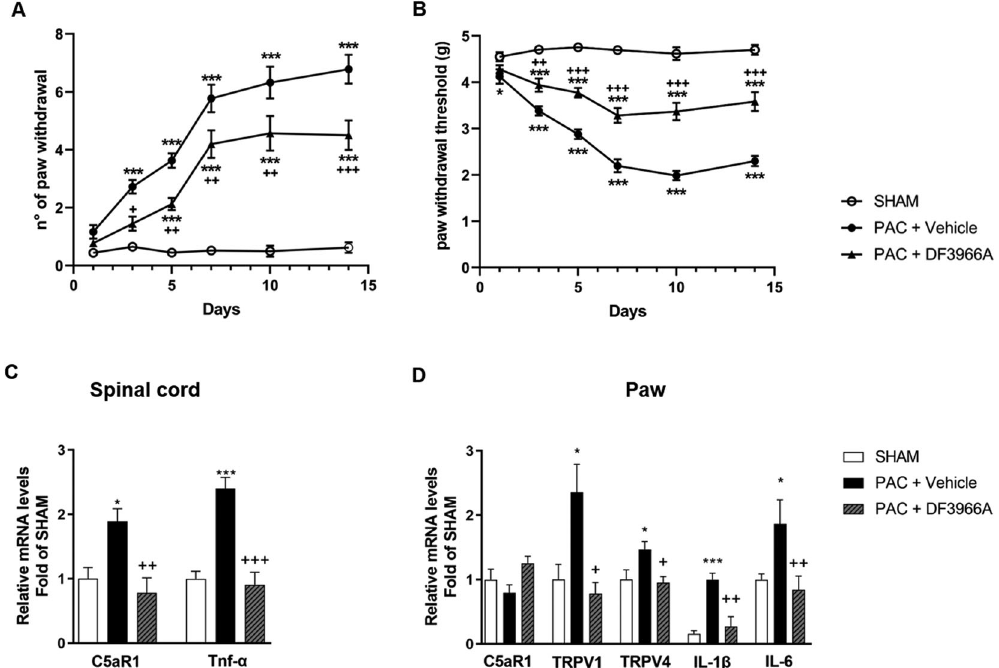
Fig. 6 C5aR1 is a key mediator of paclitaxel-induced cold and mechanical allodynia. Time course of paw withdrawal responses in mice displaying paclitaxel (PAC)-induced cold ( A ) (two-way ANOVA, effect of time × treatment F (10,285) = 21.69; p < 0.0001 followed by Bonferroni ’ s multiple comparisons test) and mechanical ( B ) (two-way ANOVA, effect of time × treatment F (10,285) = 17.63; p < 0.0001 followed by Bonferroni ’ s multiple comparisons test) allodynia treated or not with a C5aR1 inhibitor, DF3966A (30 mg/kg). DF3966A was orally administered every 12 h for 14 days during the induction phase of CIPN. Cold and mechanical allodynia were evaluated 3 h after DF3966A treatment on days 1, 3, 5, 7, 10 and 14. ( C ) Real time-PCR analysis of C5aR1 (one-way ANOVA, effect of treatment F (2,27) = 6.381; p = 0.0054 followed by Bonferroni ’ s multiple comparisons test) and TNF- α (one-way ANOVA, effect of treatment F (2,27) = 14.79; p < 0.0001 followed by Bonferroni ’ s multiple comparisons test) expression levels in the spinal cord, and of ( D ) C5aR1 (one-way ANOVA, effect of treatment F (2,27) = 3.480; p = 0.0452 followed by Bonferroni ’ s multiple comparisons test), TRPV1 (one-way ANOVA, effect of treatment F (2,27) = 6.349; p = 0.0055 followed by Bonferroni ’ s multiple comparisons test), TRPV4 (one-way ANOVA, effect of treatment F (2,27) = 4.050; p = 0.0290 followed by Bonferroni ’ s multiple comparisons test), IL-1 β (one-way ANOVA, effect of treatment F (2,27) = 13.81; p < 0.0001 followed by Bonferroni ’ s multiple comparisons test) and IL-6 (one-way ANOVA, effect of treatment F (2,27) = 1.898; p = 0.1694 followed by Bonferroni ’ s multiple comparisons test) in paw samples collected at day 15 after the fi rst paclitaxel administration. *** P < 0.0005 and * P < 0.05 vs respective sham group; +++ P < 0.0005; ++ P < 0.005 and + P < 0.05 vs paclitaxel. Data are expressed as mean ± SEM; n = 10 per